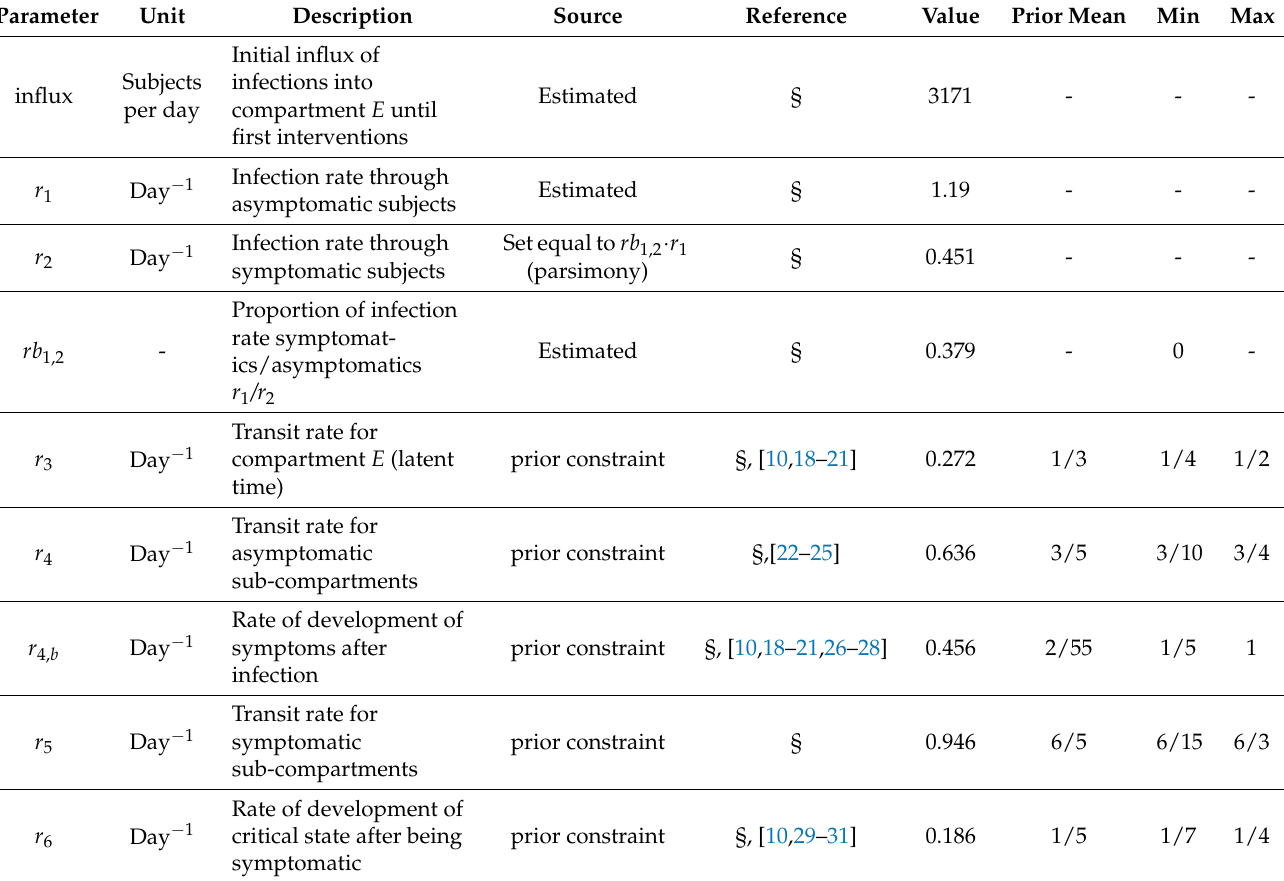
Table 2. Basic model parameters. We present prior values and ranges derived from the literature as well as estimated values derived from parameter fitting. Transit rate means reverse of transit time of the respective compartment. Posteriors can be found in Figure 4. §: Further details and definitions on parameters are given in the Appendix A Equations (A1) and (A2), where also a justification of priors is provided, (Appendix